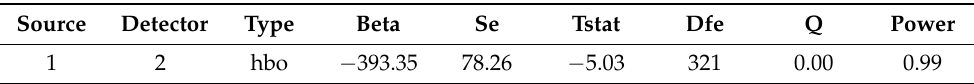
Table A11. t -test statistics for each channel (source–detector pair). Triangle Left–Triangle